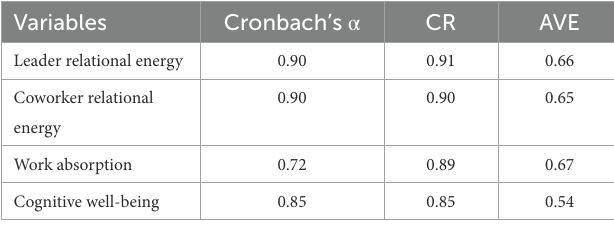
Table 3. Leader relational energy was significantly positively correlated